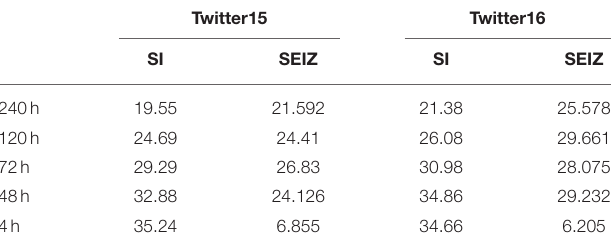
TABLE 2 | Twitter15 and Twitter16 fitting error